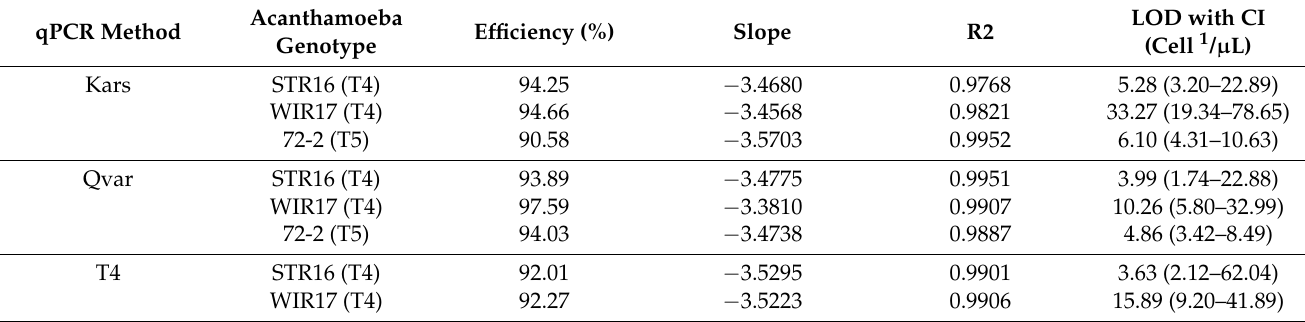
Table 1. Assay Efficiency, and limits of detection